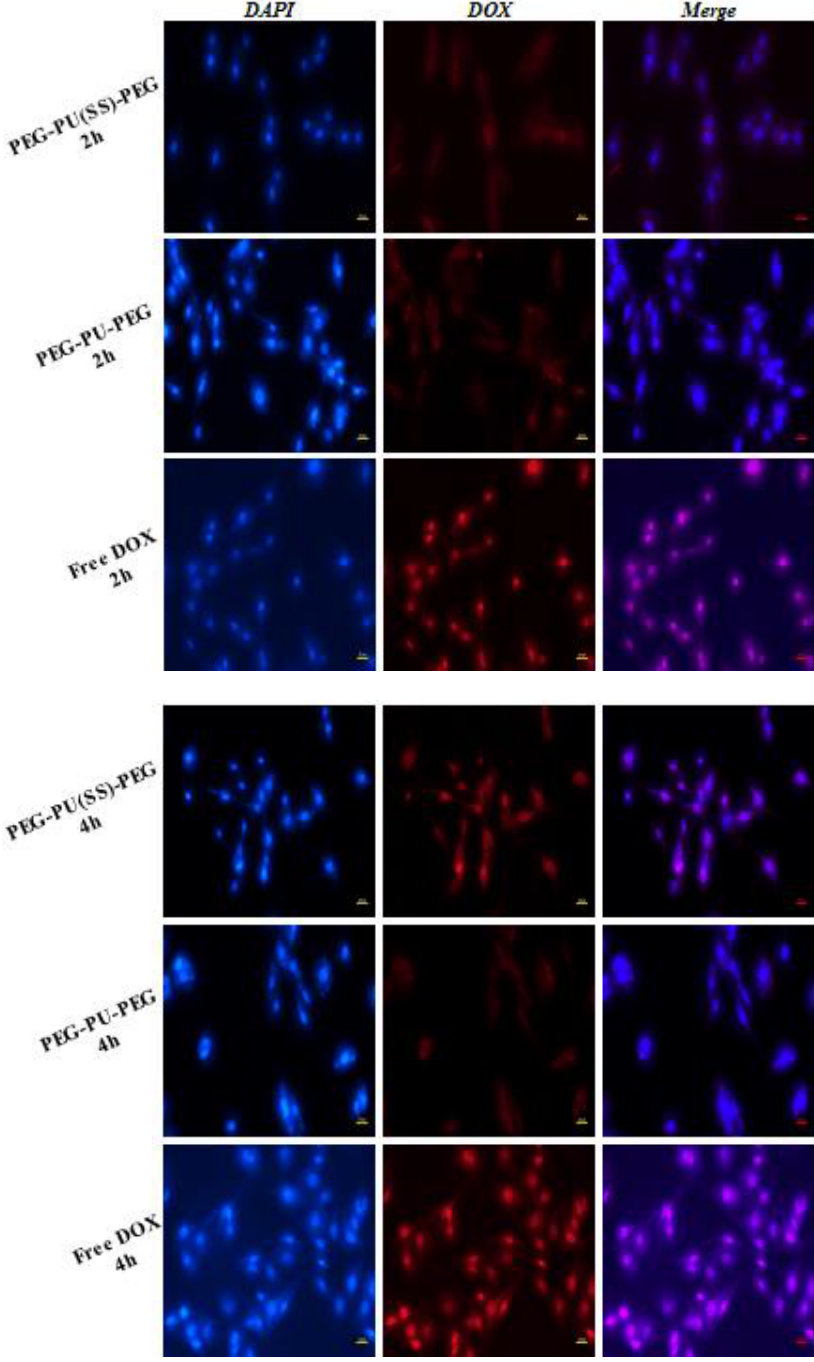
Figure 4. Fluorescence microscope images of C6 cells incubated with DOX-loaded PEG-PU(SS)-PEG micelles, DOX-loaded PEG-PU-PEG micelles, and free DOX· HCl for 2 h and 4 h (dosage: 25 μg DOX equiv/mL). For each panel, images from left to right showed cell nuclei stained by DAPI (blue), DOX fluorescence in cells (red), and overlays of two images. The scale bars correspond to 20 µ m in all images.